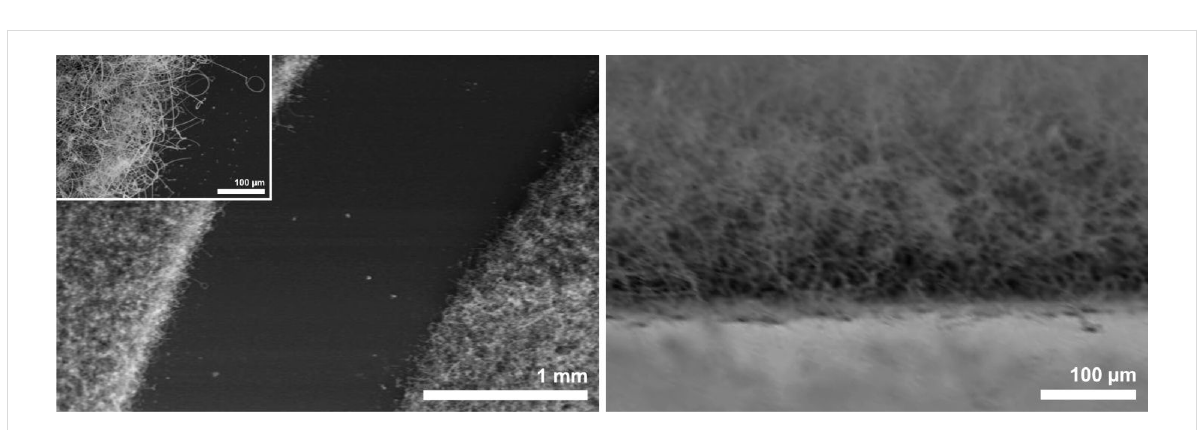
Figure 14: SEM image of the border region of a Si NW pattern obtained from UV-patterned “liquid bright gold” films after annealing at 650 °C, fol- lowed by treatment with NPS at 650 °C. Left: Top view, right: Side